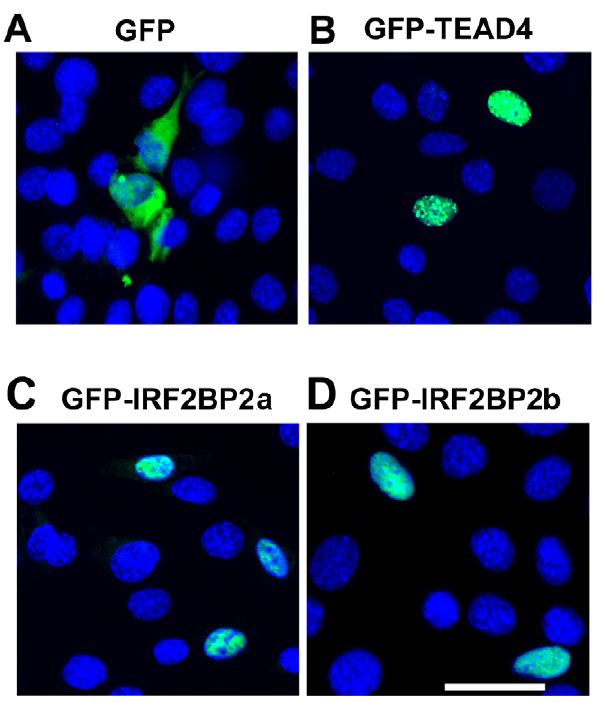
Figure 1. Green fluorescent protein (GFP) full-length IRF2BP2 fusion constructs are targeted to the nucleus. A. GFP alone was localized in the cytoplasm of C 2 C 12 myosblasts. B. A GFP fusion construct with the nuclear-targeted transcription factor TEAD4 was nuclear localized in C 2 C 12 myoblasts. C. GFP-IRF2BP2a was localized to the nucleus of C 2 C 12 myoblasts. D. GFP-IRF2BP2b was also nuclear in C 2 C 12 myoblasts. Nuclei were revealed by DAPI in blue. Scale bar, 50 m m.